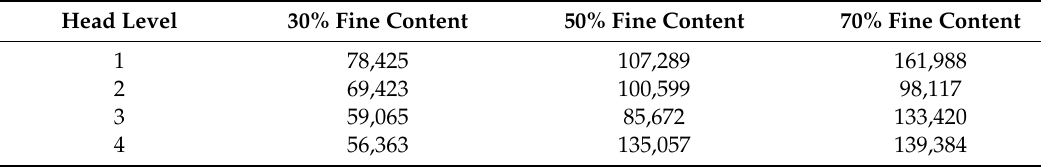
Table 20. Fine particle content change during seepage (10–20 µ